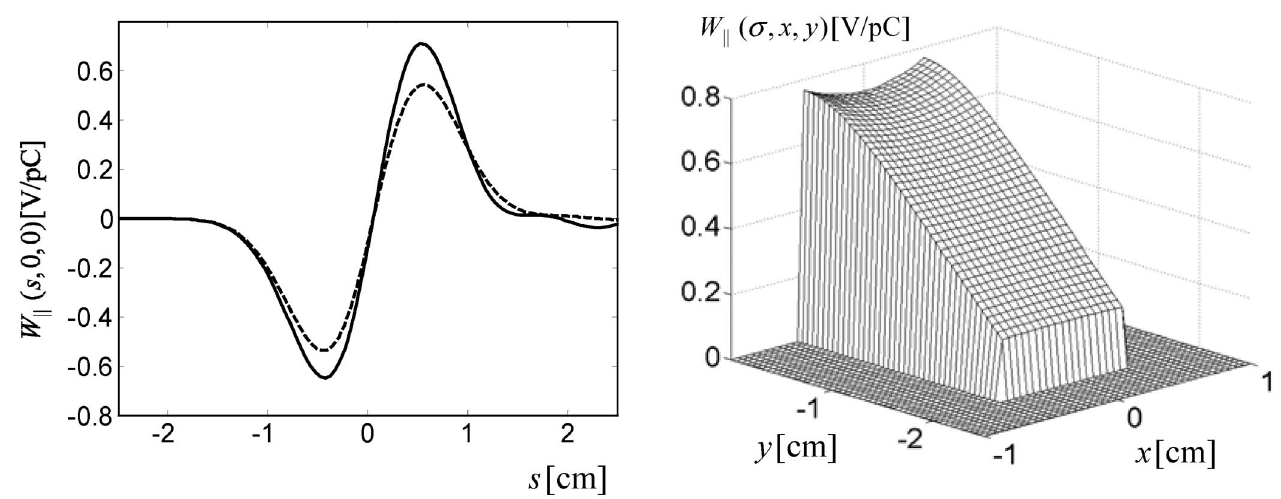
FIG. 11. The left-hand figure shows the longitudinal wake potential on the axis for a rectangular (solid line) and a circular (dashed line) collimator and a Gaussian bunch with 9 (cid:5) 5 mm . In the right-hand picture the energy gain for a test particle moving at the position s (cid:5) 9 behind the bunch center is shown.